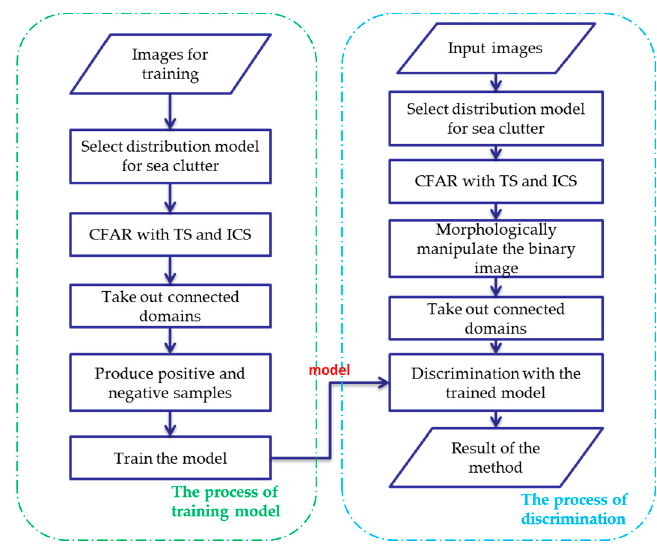
Figure 7. The discrimination stage with deep convolutional neural network.